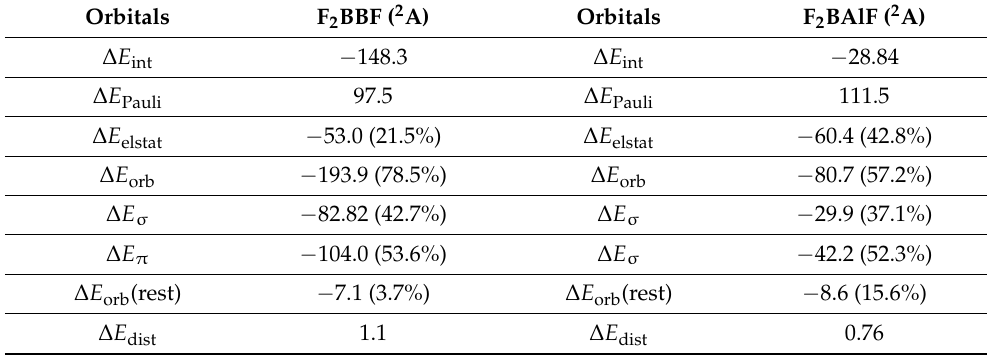
Table 2. The results of EDA-NOCV theory for F 2 BMF at